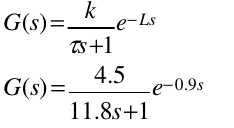
Fig. 7. Bode plot of the designed system.